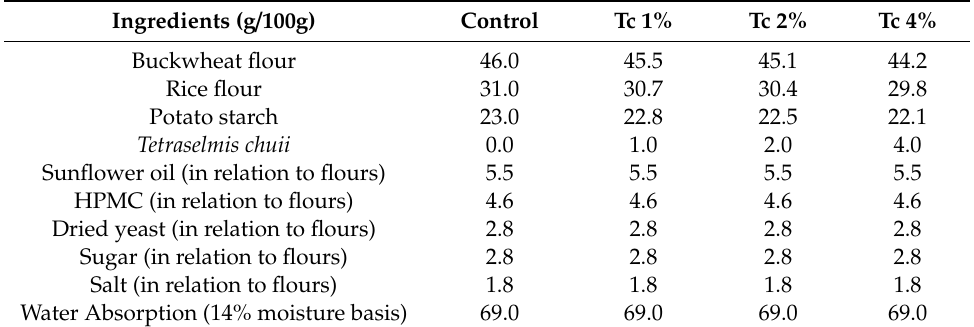
Table 1. Formulation of gluten-free (GF) samples and respective codes. Control: dough